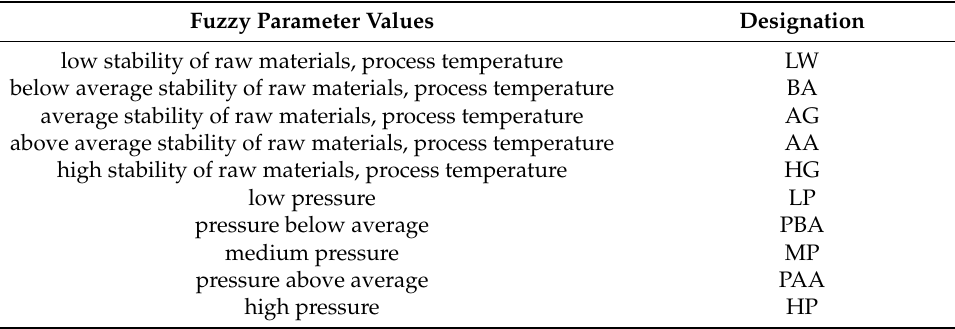
Table 1. Values of fuzzy parameters for forming the rule base.